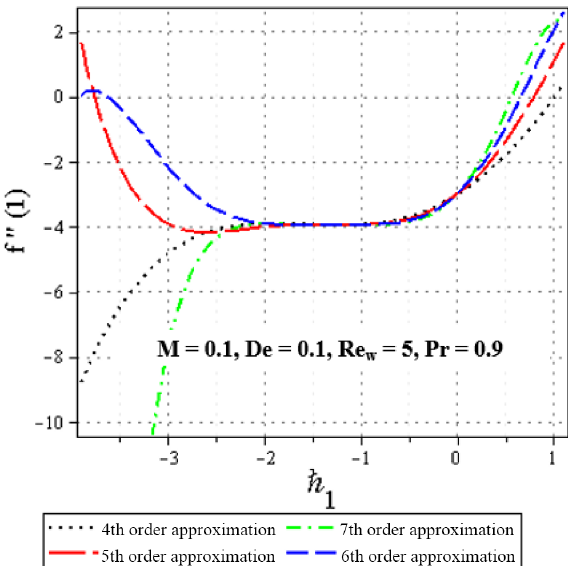
Figure 3. The (cid:125) 1 – validity for M = 0 . 1, De = 0.1, Re w = 5 and Pr = 0.9 given by the 4, 5, 6 and 7th-order solution.